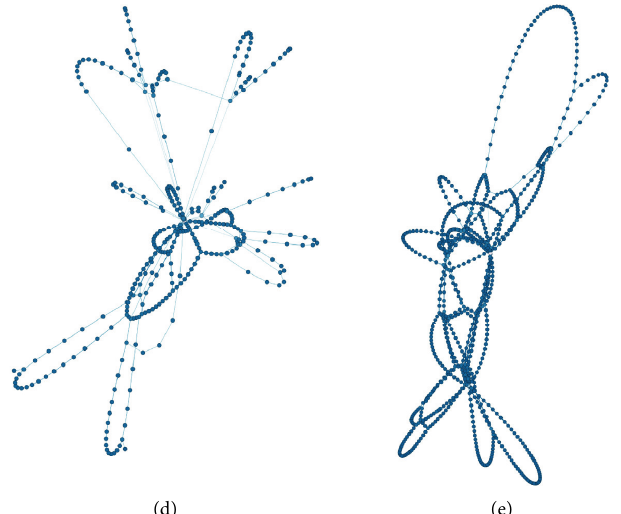
Figure 2: In L-Space, for Linja-Karjala Oy (a), AVL, CFL, RGTR, and TICE (b), STAR (c), CIT (d), and Thunder Bay Transit (e) networks.